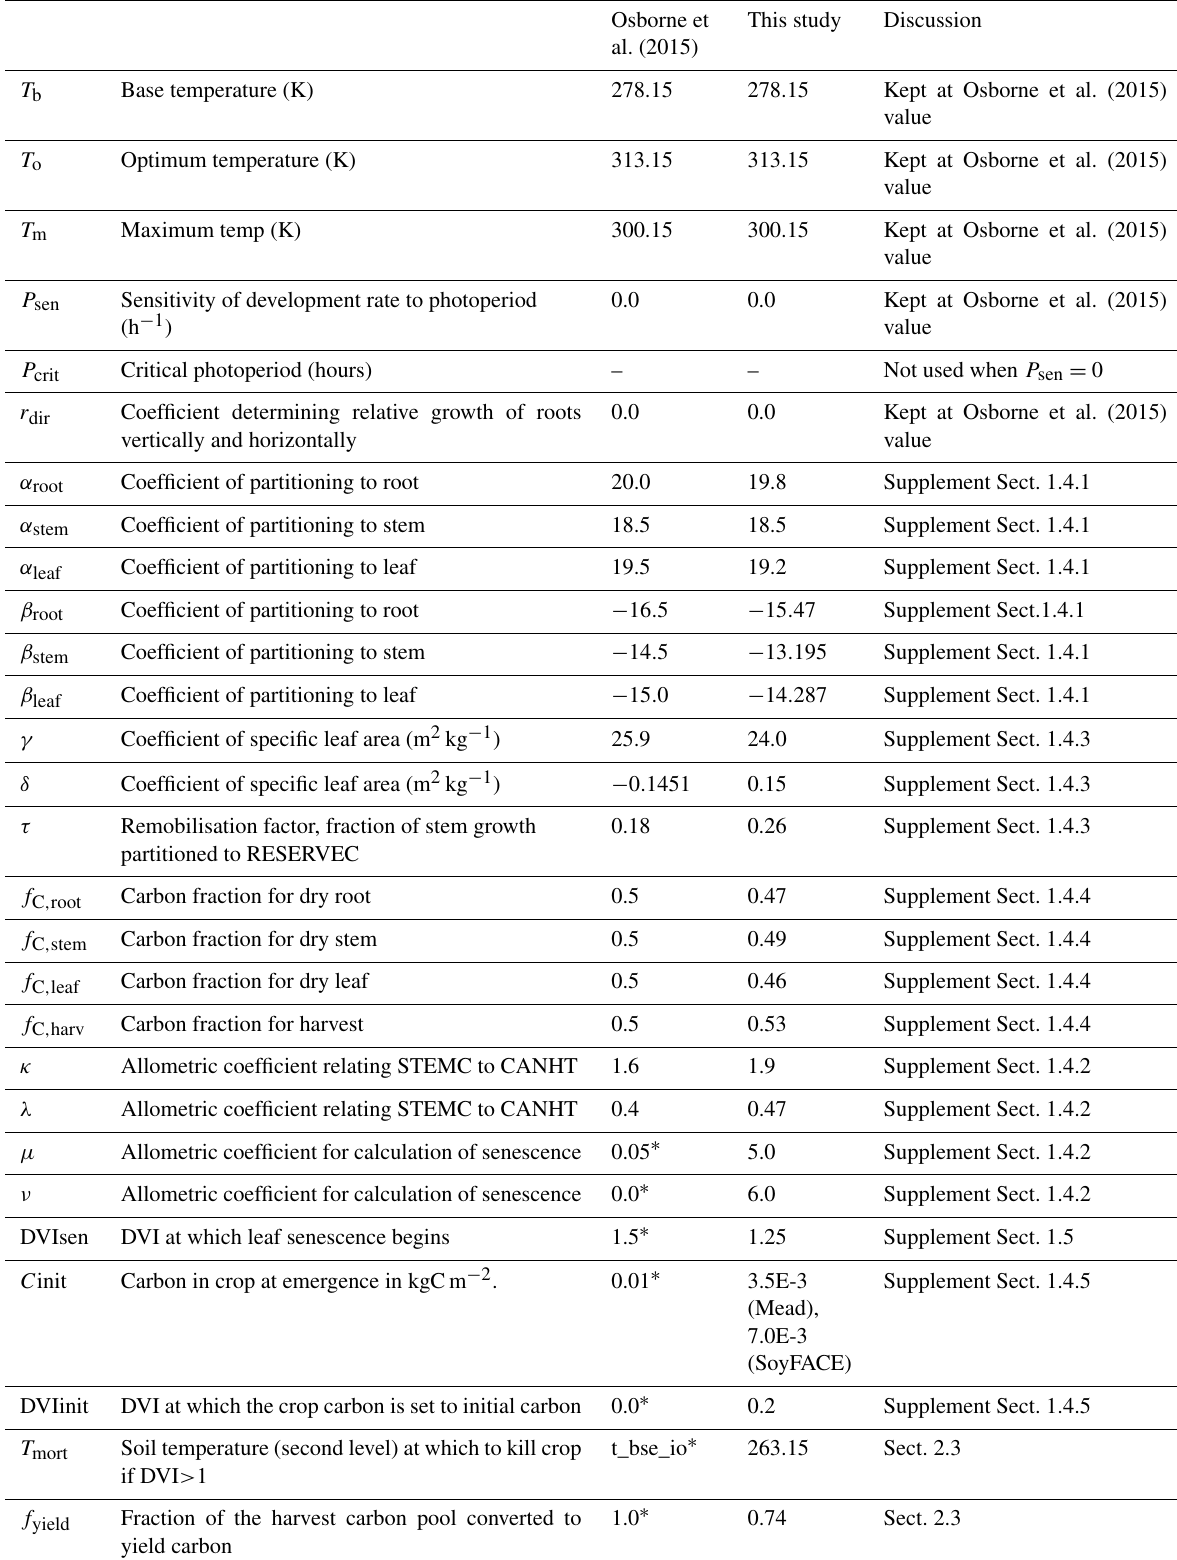
Table 2. Parameter values in JULES-crop that are used to represent soybean. Asterisk indicates parameter was